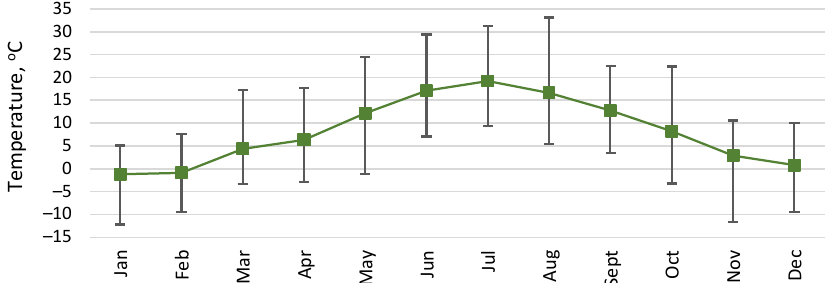
Figure 6. Average monthly outdoor temperature according to [43].